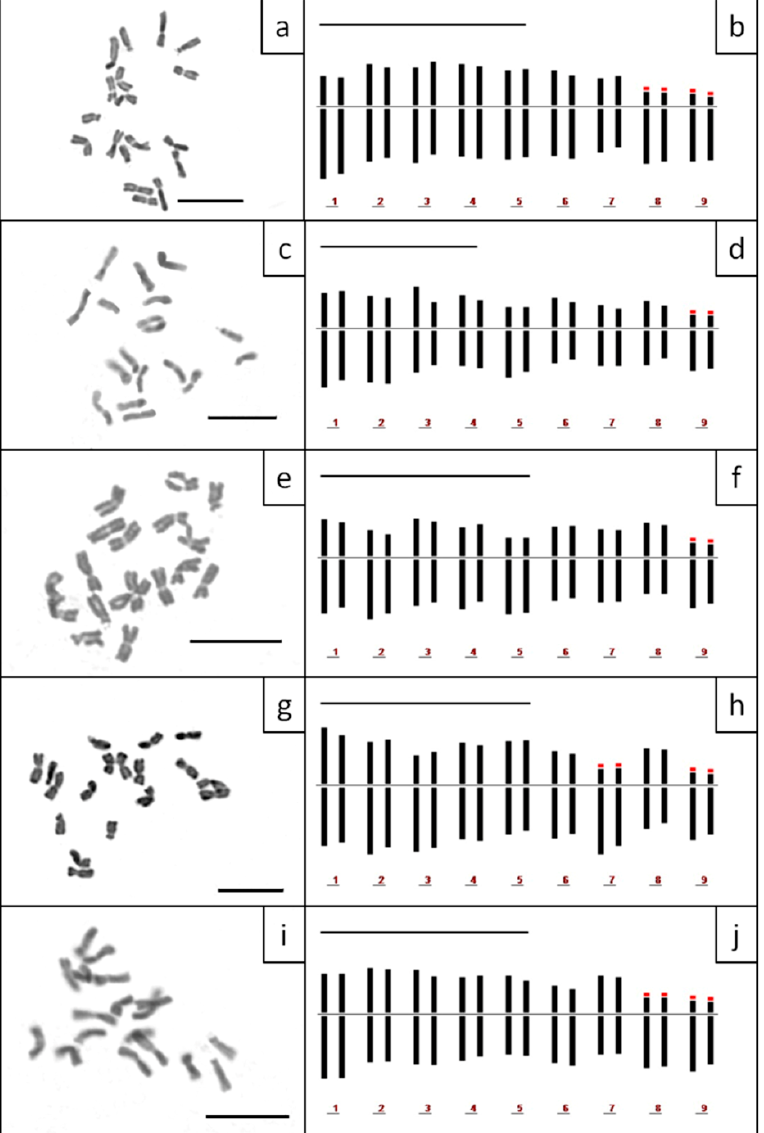
Figure 7. Metaphase plates and idiograms of Anthemis macedonica subsp. macedonica ( a , b ), A. mace- donica subsp. thracica ( c , d ), A. meteorica ( e , f ), A. orbelica ( g , h ) and Anthemis 1 from the ultramafic areas of Central Greece ( i , j ). Red parts of the idiograms indicate satellites. Scale bars = 10 μ m.